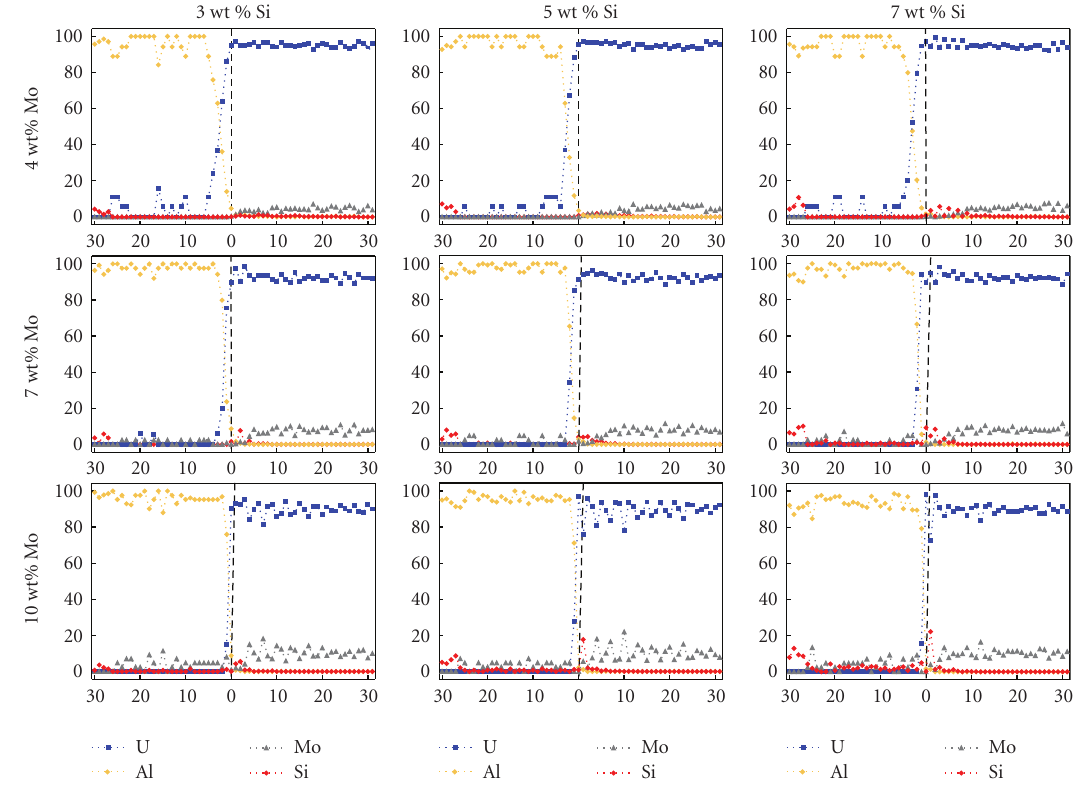
Figure 8: Composition profiles of the computational cells at T = 450K shown in Figure 7 for (from left to right) 3, 5, and 7 wt% Si, and (from top to bottom) 4, 7, and 10wt% Mo. Al, Si, U, and Mo atoms are denoted with yellow, red, blue, and grey circles, respectively. The original location of the interface (at the onset of the simulation) corresponds to the label “0”. The change of the concentration profile width with Mo and Si content is shown. Increasing numbers to the left and to the right of this reference layer denote matrix and fuel